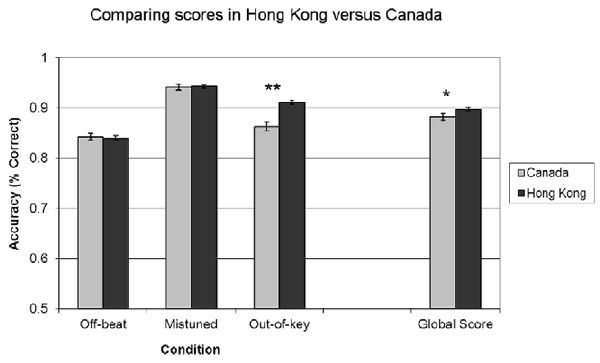
Figure 2. Comparisons of Hong Kong and Canadian partici- pants (younger participants only) on the Online Amusia Test. Error bars indicate standard error of the mean. Only the Out-of-Key condition shows a significant group difference (**p , .001); note that after controlling for age, education, and musical training differences, the group difference in the Out-of-Key condition remained. The Global Score also showed a significant group difference (*p=.007).